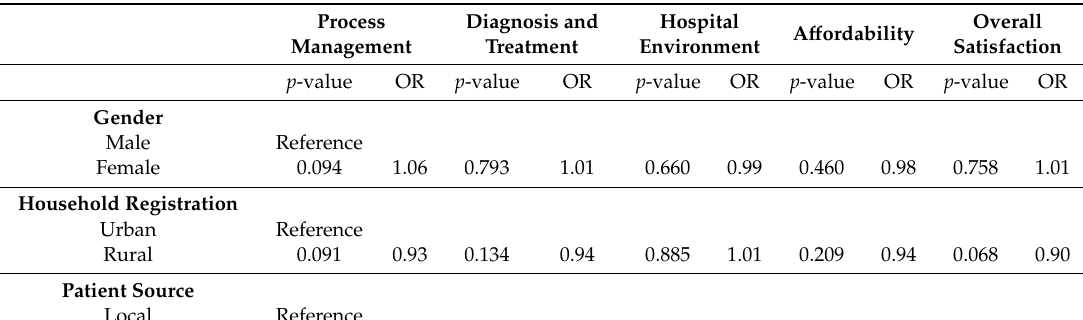
Table 4. Multilevel logistic regression analysis of domain scores with key socio-demographic outpatient variables. ( p -value < 0.05 bolded and considered statistically